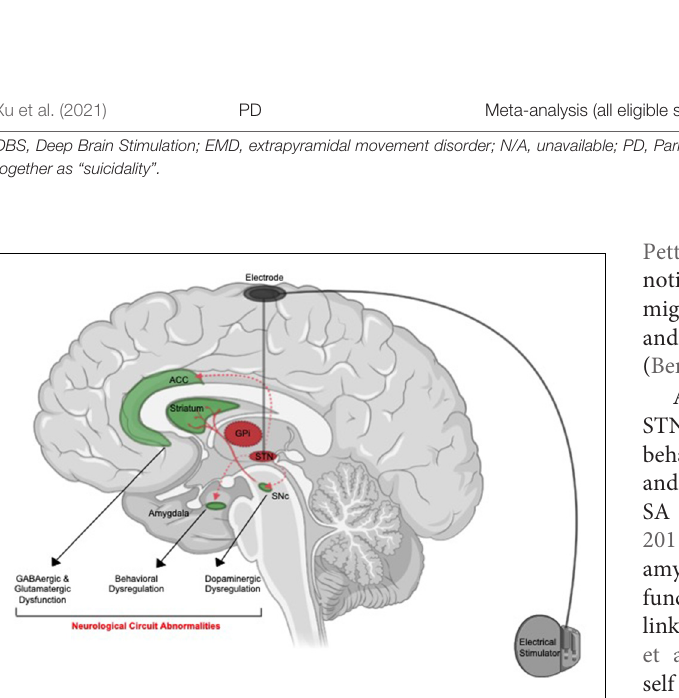
FIGURE 1 | Putative neuroanatomical mechanisms of suicide associated with deep brain stimulation (DBS). Off-target stimulation of brain regions connected with anterior cingulate cortex (ACC, amygdala) or adjacent to (SNc) the suicide risk in patients who received subthalamic nucleus (STN) might cause induction of neurological pathways associated with suicide. Activation of the ACC might cause a disturbance in GABAergic and glutamatergic signaling. Activation of the amygdala might result in behavioral abnormalities. Activation of SNc and dorsal striatum circuit can result in dopaminergic dysfunction. These neurobiological changes might translate into elevated psychosocial distress and potentiate suicidal ideation (SI) and suicidal behavior